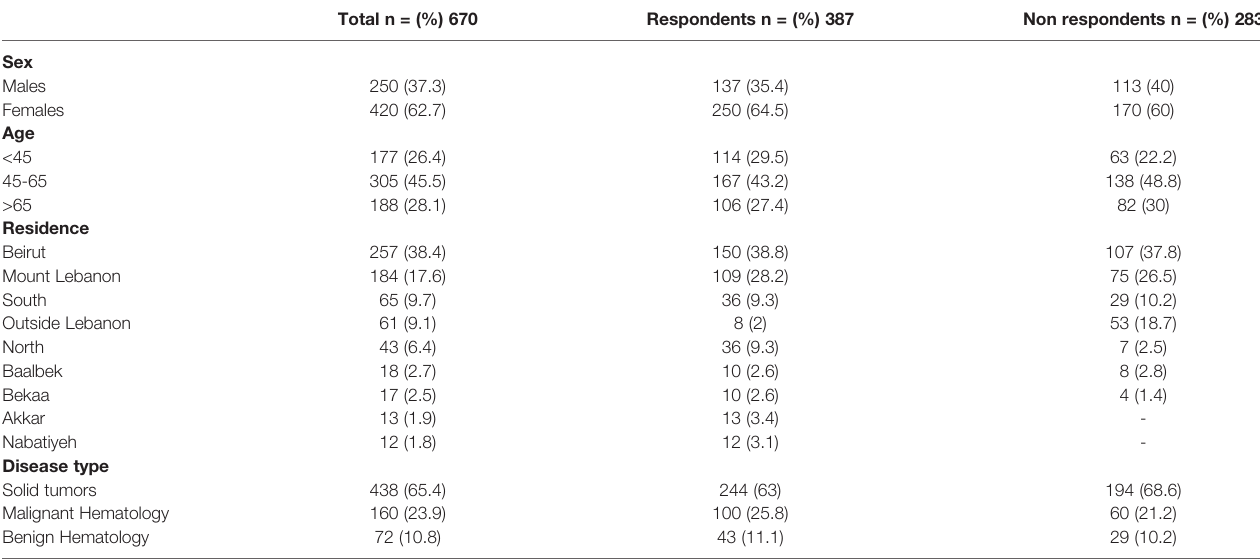
TABLE 1 | Patient